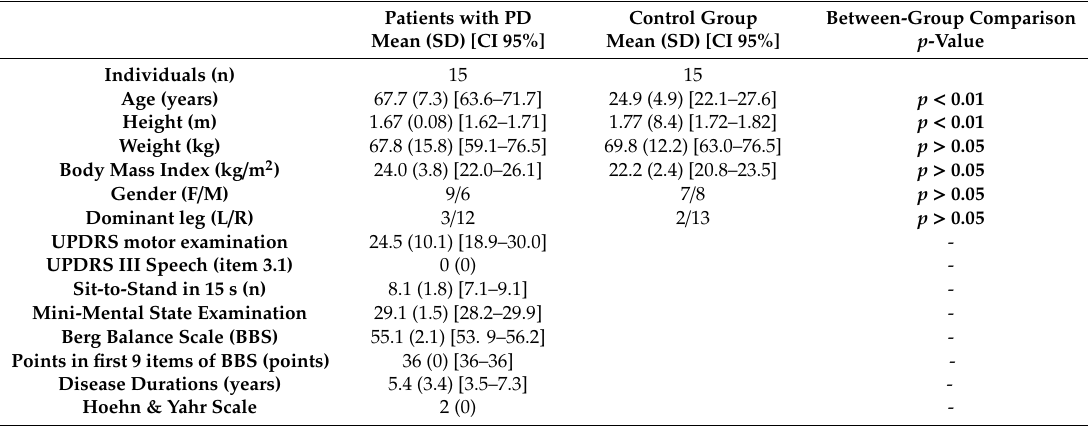
Table 1. Demographic characteristics of patients with Parkinson’s disease and the control group.